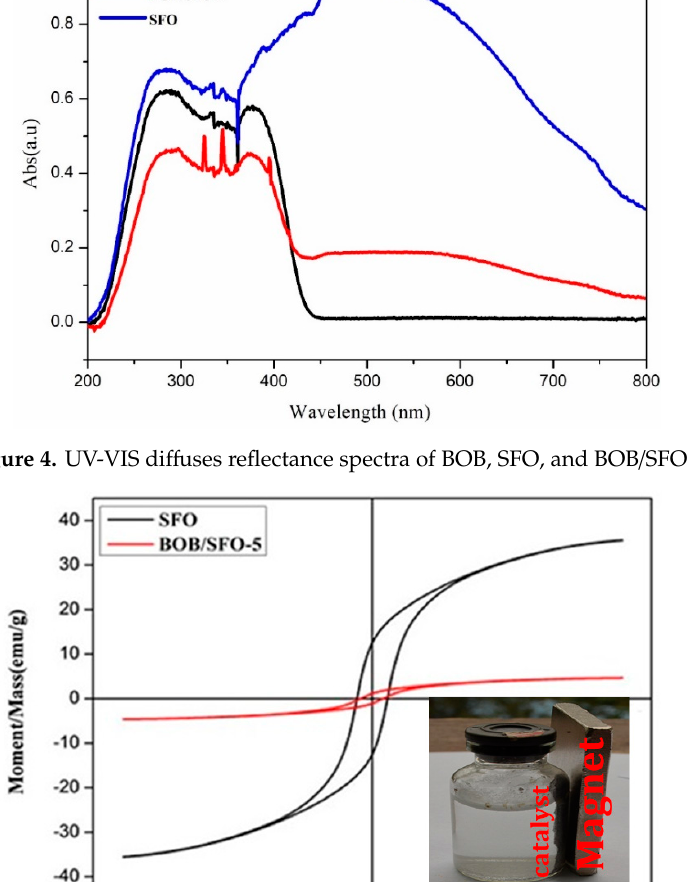
Figure 4. UV-VIS diffuses reflectance spectra of BOB, SFO, and BOB/SFO-5.